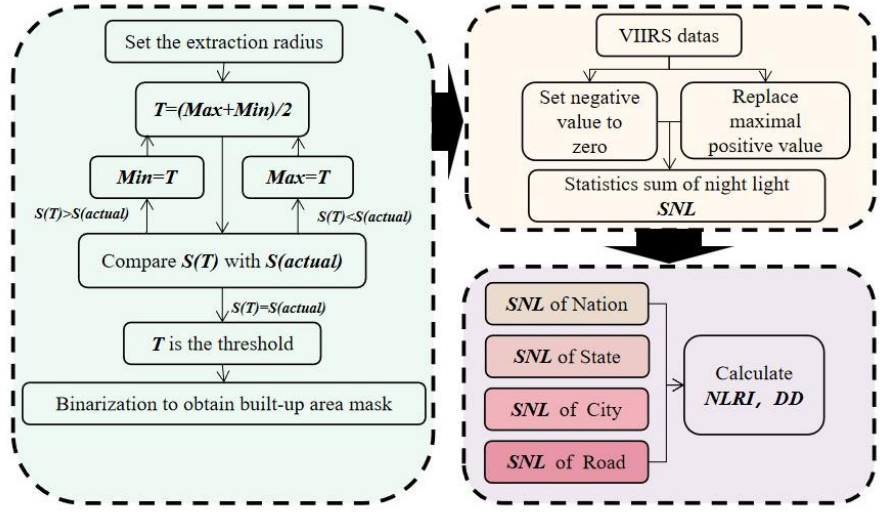
Figure 2. Conceptual diagram of the proposed multi-scale analysis frame.